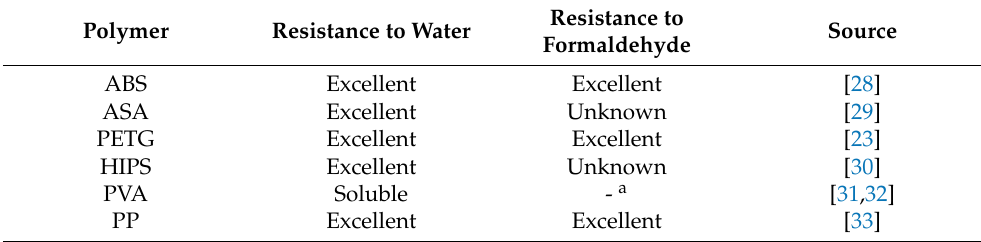
Table 2. Chemical resistance of pre-selected polymers according to